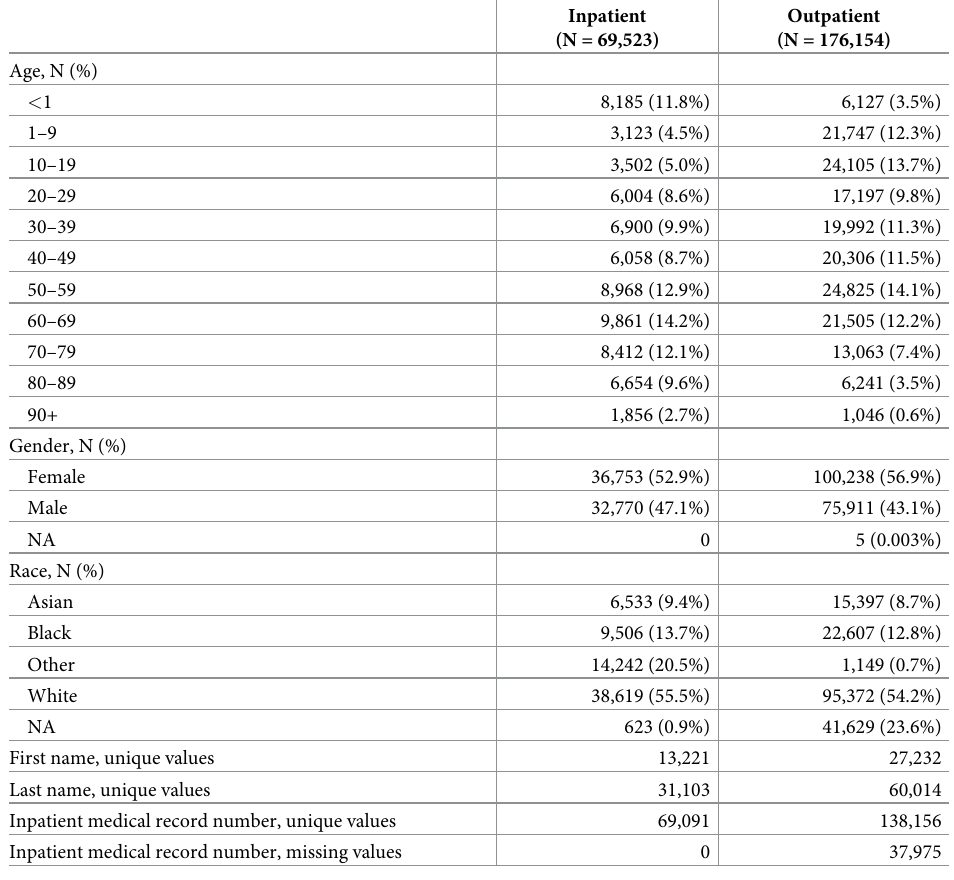
Table 1. Demographic characteristics by